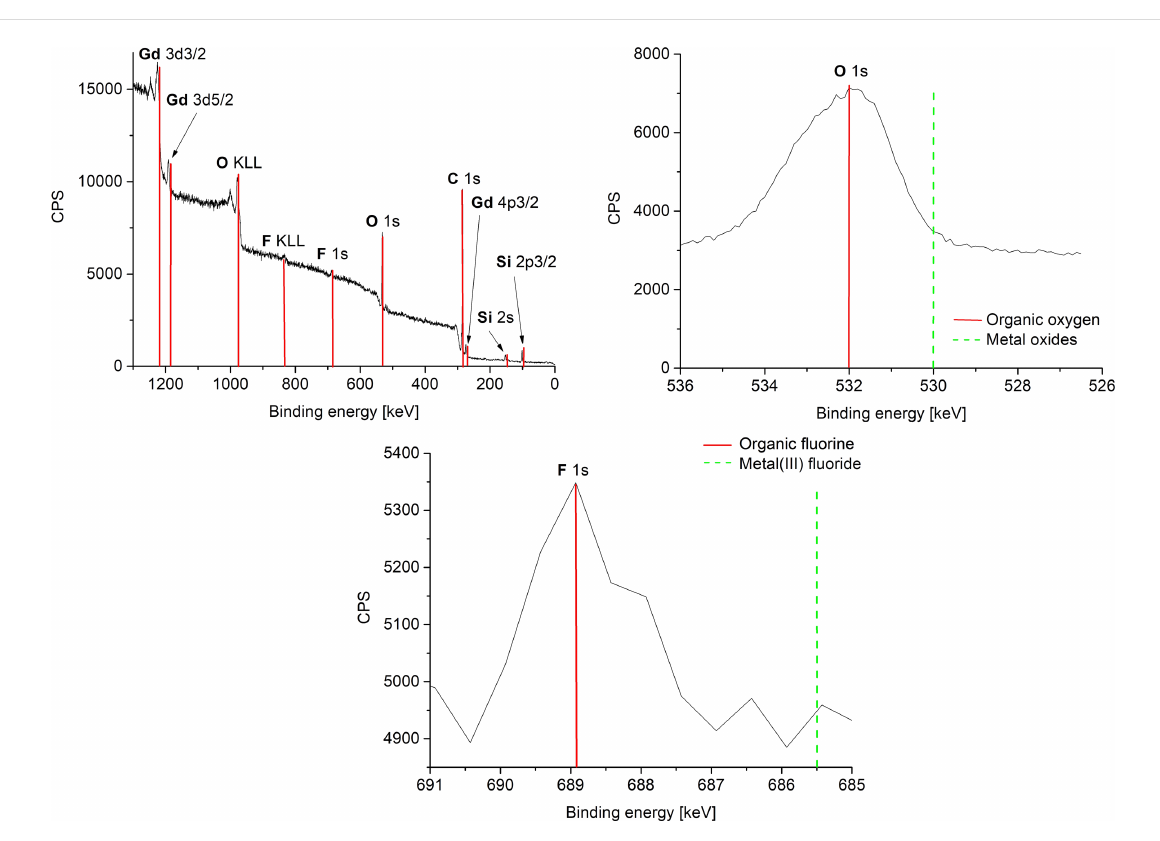
RE = Gd(0) and Er(0) [48,49]. Thus, HR-XPS data in combina- tion with SAED exclude any significant contamination of Gd(0)-NPs and Er(0)-NPs with oxides or fluorides. We note that the amount of metal oxides is below the detection limit and that small amounts of water in the ILs of up to 30 ± 18 ppm for [BMIm][BF 4 ] does not lead to a detectable formation